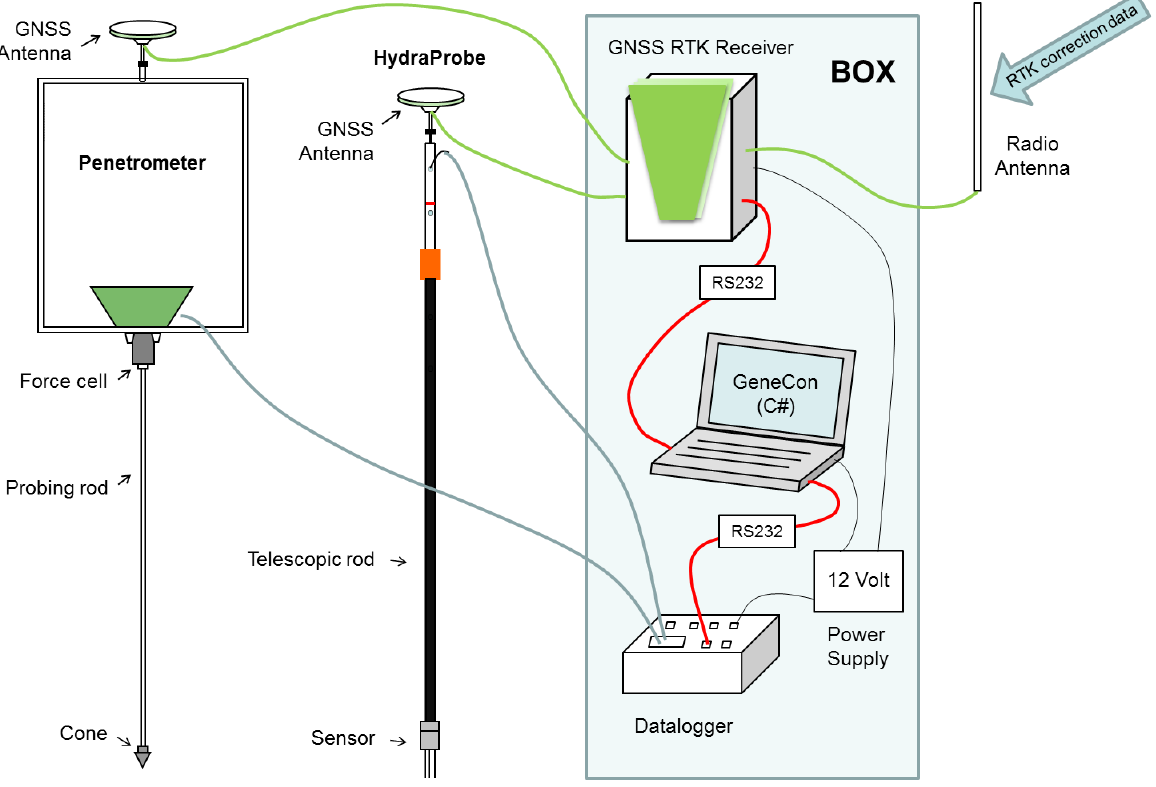
Figure 1. Scheme of the measurement system: sensors and electronic equipment for data acquisition (GNSS RTK receiver, data logger, notebook running GeneCon-software and power supply) stored in a splash-proof water-tight